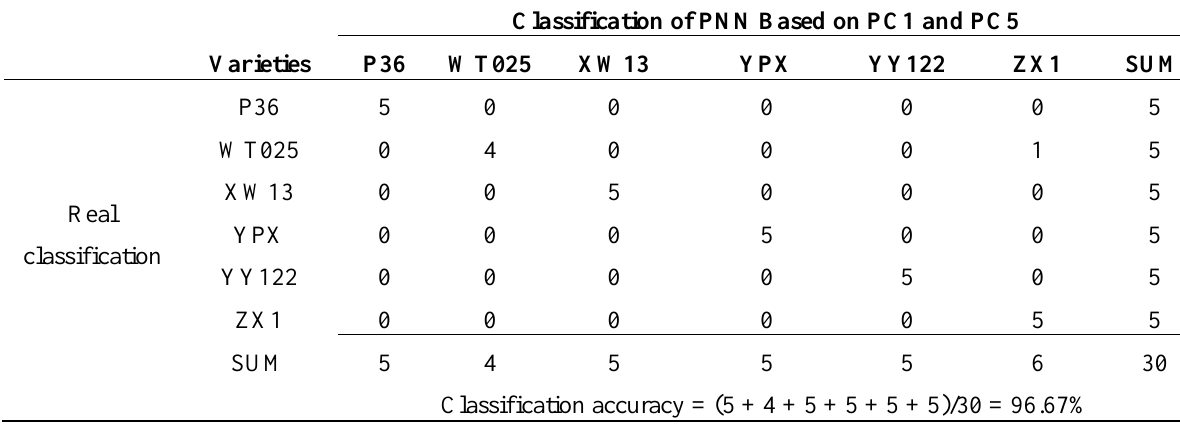
Table 4. Classification result of the test set (PC1 and PC5) using PNN (Spread = 4 × 10 −5 ). Classification of PNN Based on PC1 and PC5 Varieties P36 WT025 XW13